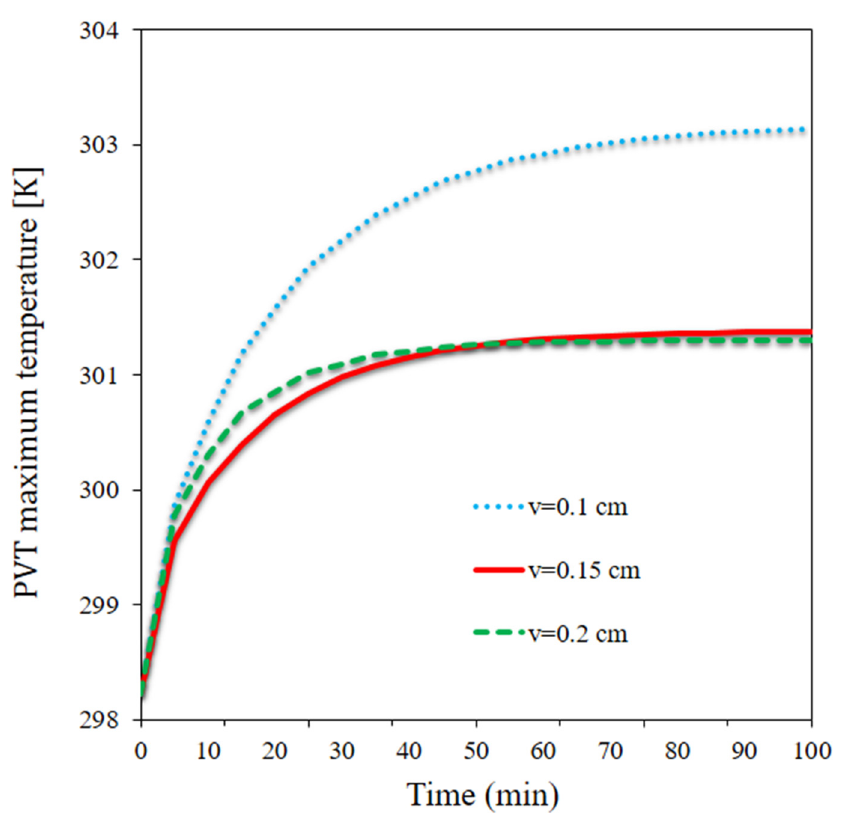
Figure 4. The maximum panel temperature at different velocities over time.